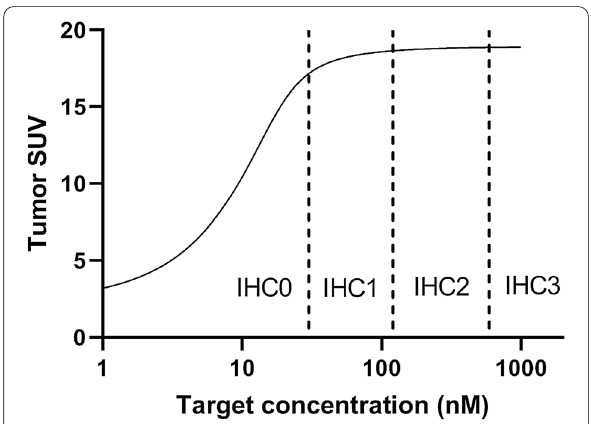
Fig. 4 Tumor uptake of 89 Zr‑trastuzumab as a function of HER2 concentration. Total administered mass dose 50 mg. Vertical dashed lines indicate the boundaries between the IHC